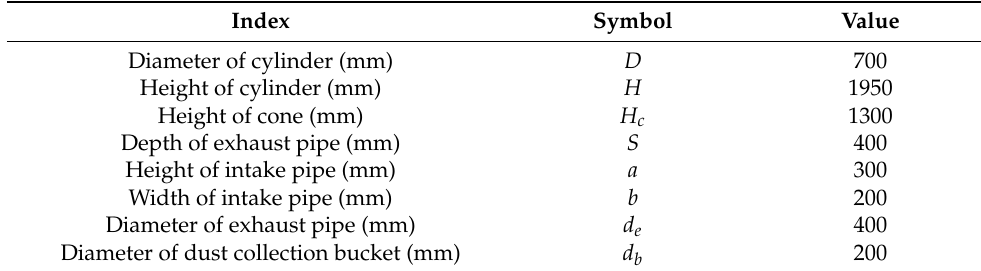
Figure 2. Image of ( a ) working principle and ( b ) structure of the cyclone separator. Table 1. Key dimensions of the cyclone separator.